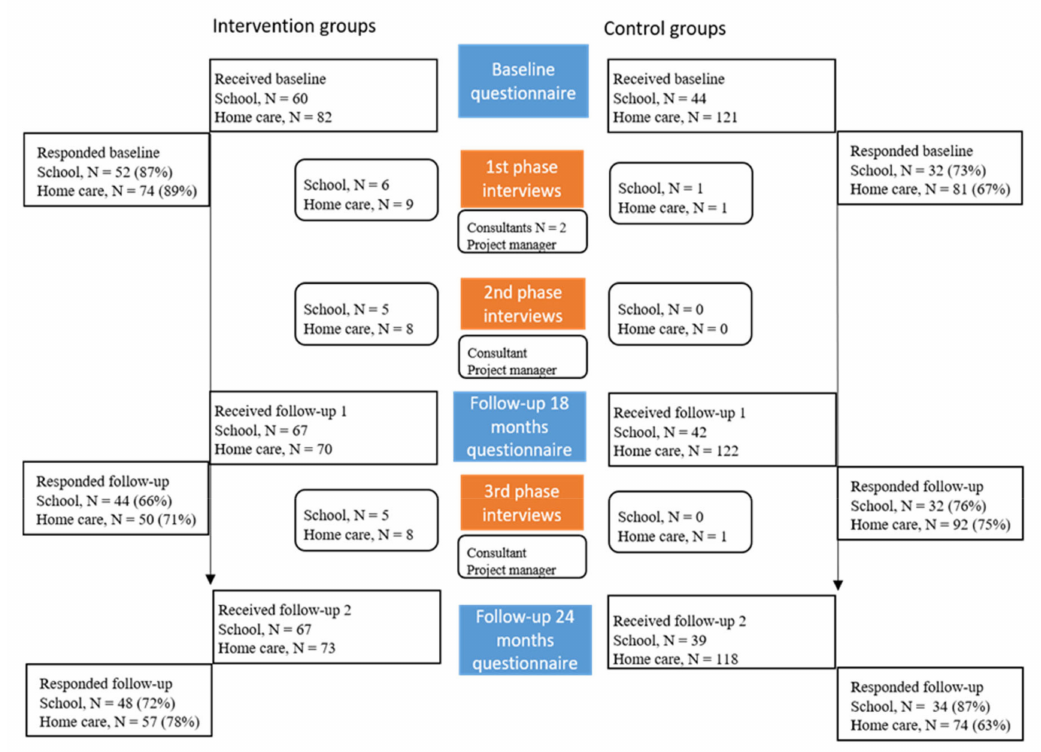
Figure 2. Flow diagram of the workers involved in the effectiveness and process